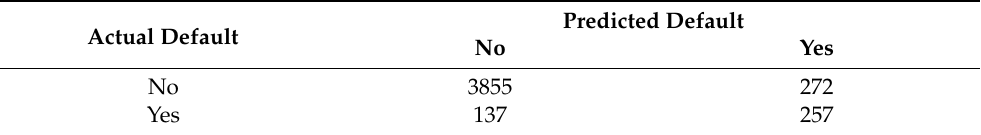
Table 12. Confusion matrix with CART model and added boosting.